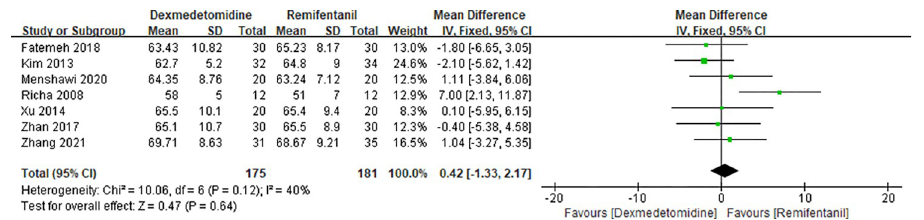
Fig 5. Forest plot of effects on HR. Dexmedetomidine group vs. remifentanil group.